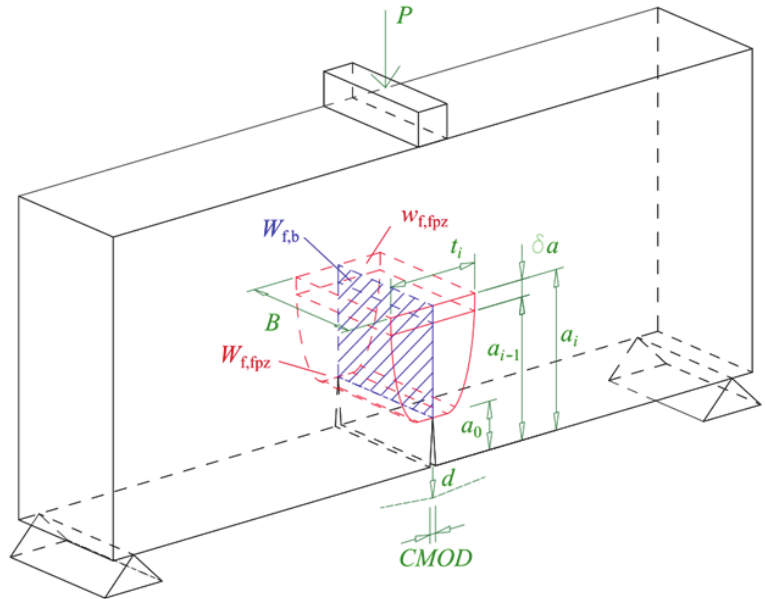
Figure 1: Sketch of the used model of the (effective) crack propagation and the cumulative FPZ extent advancement during the quasi- brittle fracture process in the SEN-TPB test